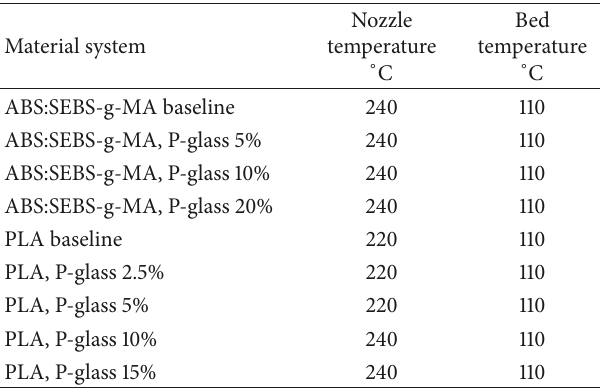
Table 2: Printing